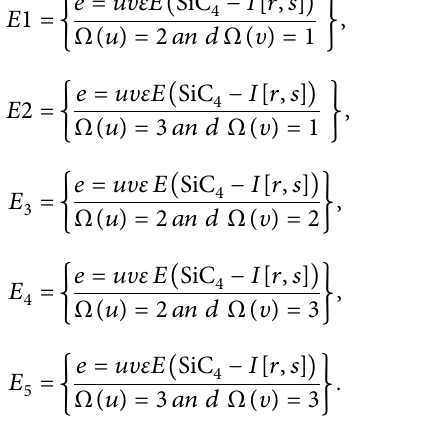
� 3and s � 1 and (b) contains two rows of silicon 4 – I [3,1] with one row where r